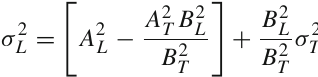
tracks are down-going, with a number being very near per- fectly vertical. These tracks are difficult to profile and give poor results for σ T .